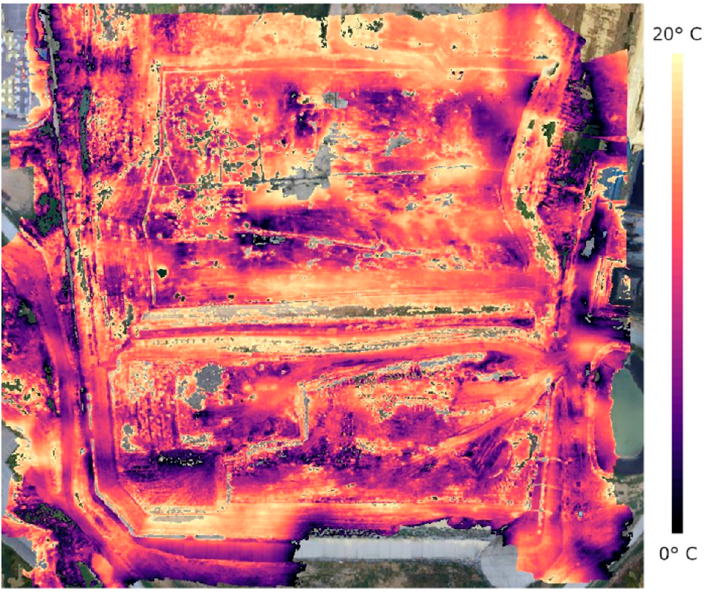
Figure 7. Mosaic thermal image of the landfill (Scala Erre) during the winter survey (February 2020). Individual visible and thermal images acquired by the UAV over specific areas during the winter season are shown in Figures 8 and 9. Figure 8 refers to a central area of the landfill, already buried, in which only flat bare soil and low vegetation were present. The left-hand side of the figure shows the visible (RGB) image of the inspected site, while on the right-hand side the corresponding thermal (IR) image is reported. Processing thermal data over portions of soil surface having a homogenous structure (as inferred by the visible image) gave a mean value and excursion of surface temperature not significantly far from those recorded for the “undisturbed” soil. For instance, the area framed inside the rectangle (termed 2A) of Figure 8 (right-hand) is characterised by calculated minimum, ◦ ◦ ◦ maximum, and average temperatures of 3.1 C, 6 C, and 4.4 C, respectively. It is conjectured that in homogeneous zones of the inspected landfill the soil temperature does not vary significantly with respect to the background